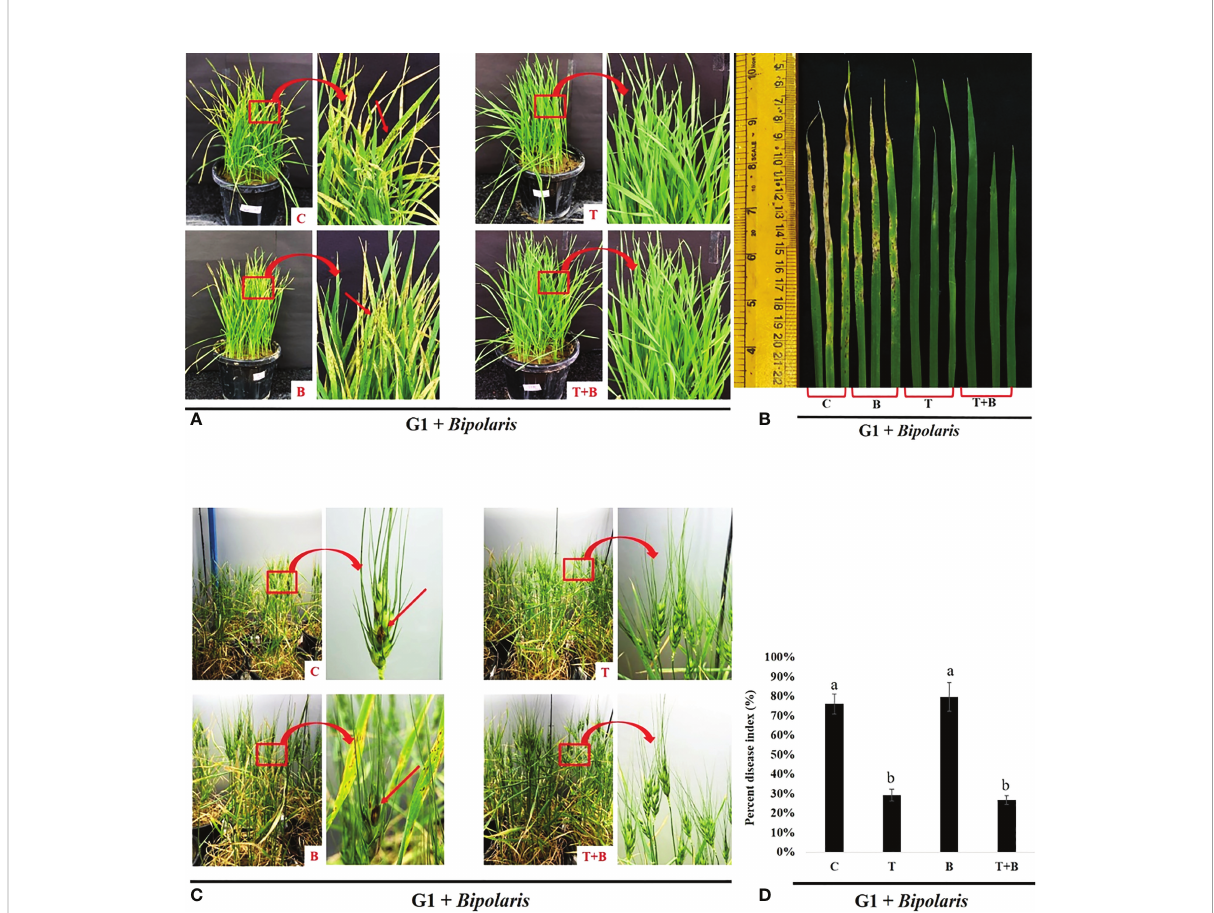
FIGURE 6 Disease assessment of spot blotch disease in the progeny (G1) of primed and non primed wheat (G0). (A, B) Symptoms of spot blotch disease on the leaves of G1 of primed and non-primed wheat (G0) after challenging with Bipolaris sorokiniana HD 3069. (C) Symptoms of spot blotch disease on spike of Gl of primed and non-primed wheat (G0) after challenging with Bipolaris . (D) Percent disease index of G1 wheat after challenging with Bipolaris . (G1 + Bipolaris ) = progeny of G0 challenged with Bipolaris sorokiniana HD 3069. In fi gure a and c red arrow indicate symptoms of spot blotch. C = control, T = Trichoderma -primed, B = Non-primed wheat challenged with Bipolaris , T+B = Trichoderma -primed and challenged with Bipolaris . Data in d is represented as mean ± SD and different alphabets indicate statistically signi fi cant difference at P<0.05 in Tukey's test. Results are representatives of three independent biological replicates. n =